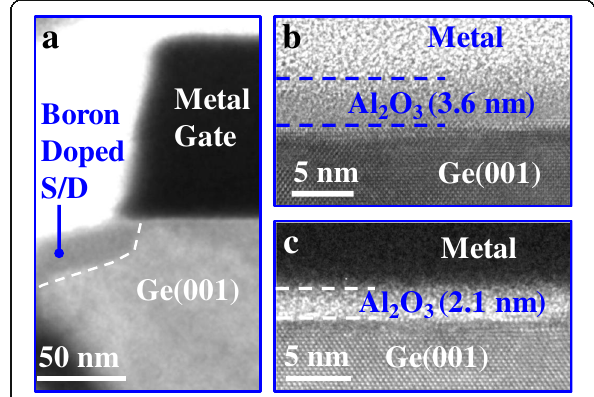
Fig. 2 a XTEM image showing gate, channel, and source/drain regions of NEI-FeFET. b and c XTEM images of gate stack of FeFETs with 3.6- and 2.1-nm-thick NEI layers,